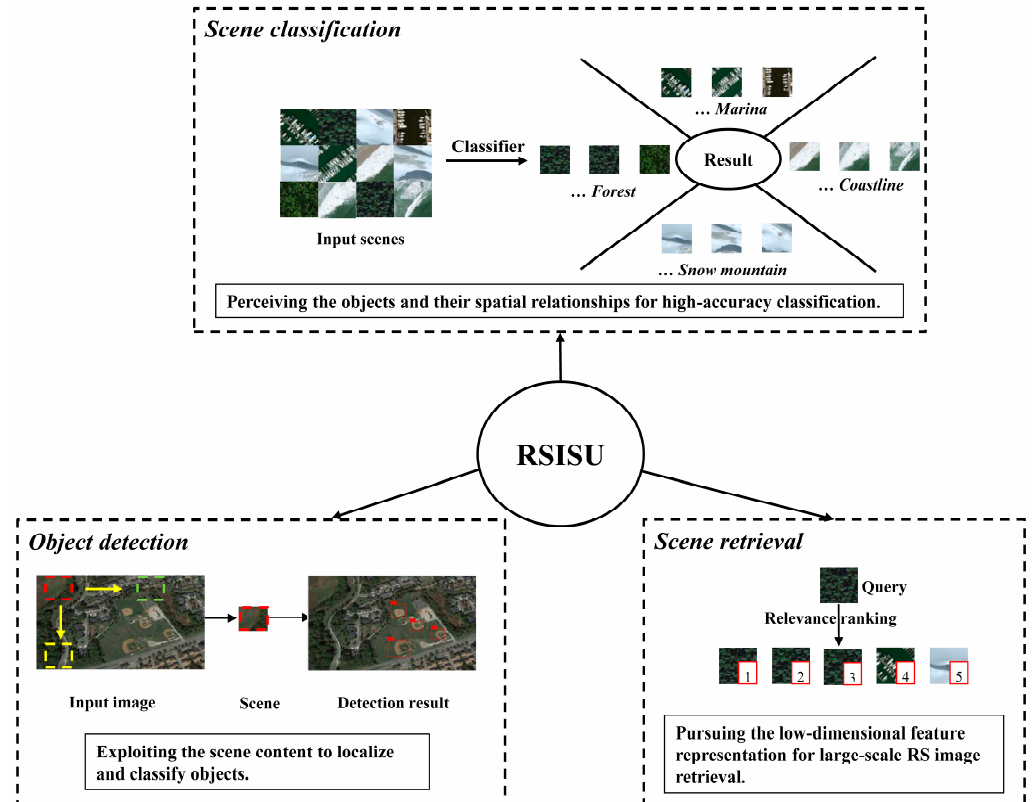
Figure 1. Taxonomy of methods for remote sensing image scene understanding (RSISU). This